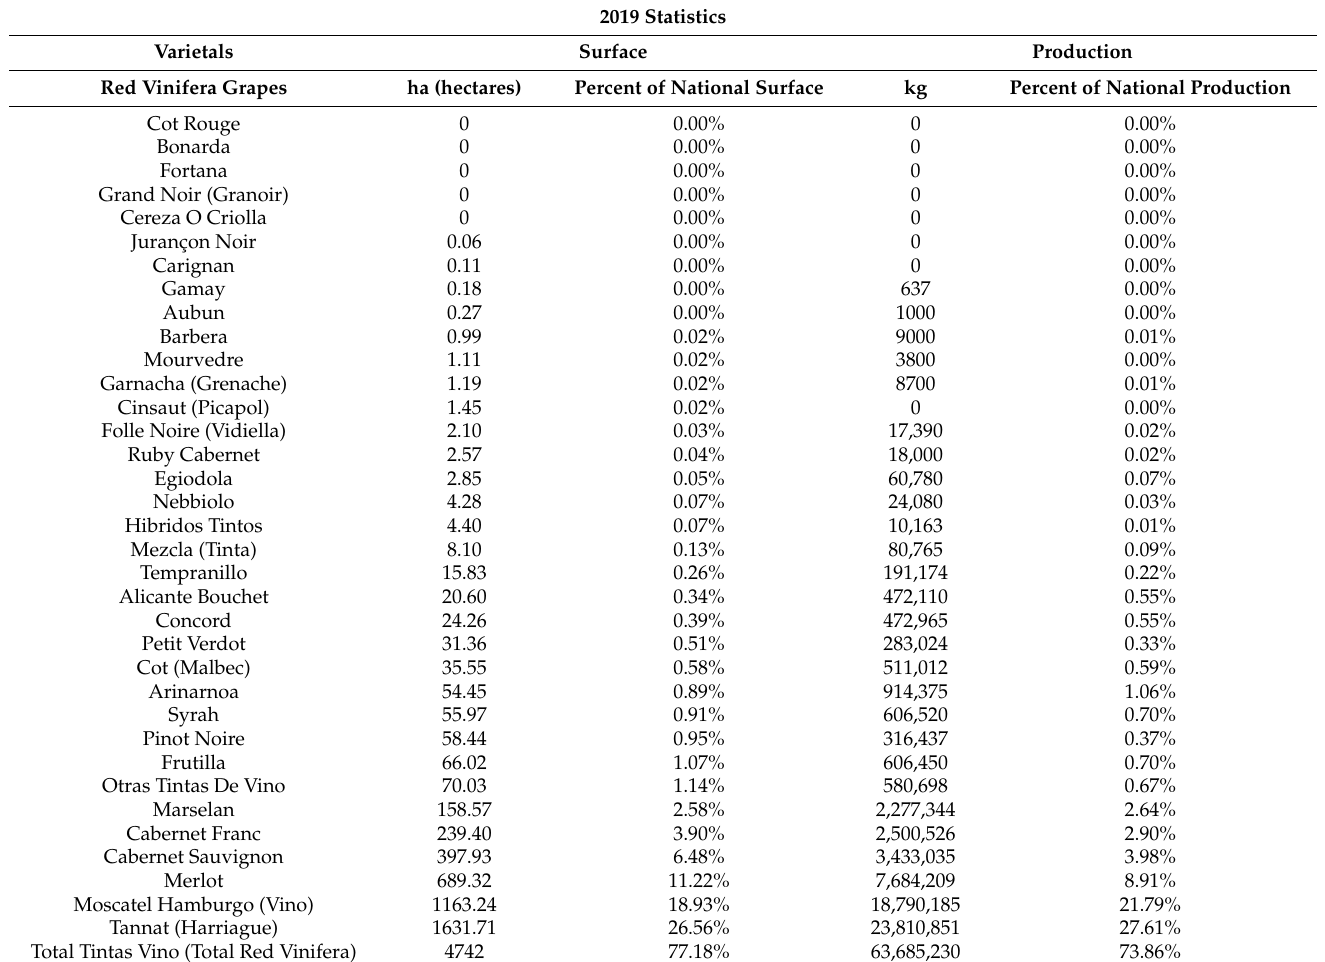
Table 5. List of red grape varietals currently cultivated and vineyard surface in Uruguay.